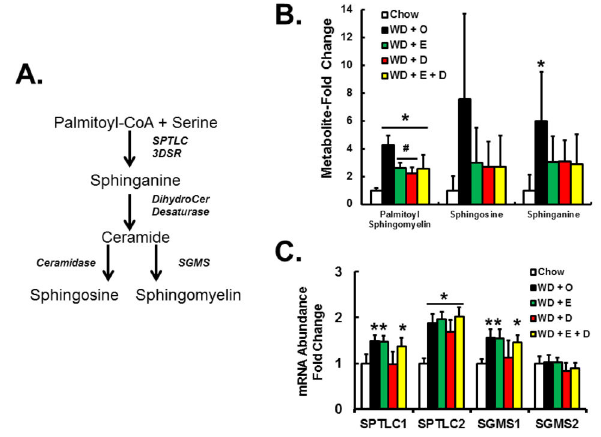
Figure 7. Diet effects on hepatic one-carbon, choline and glutathione metabolism. Panel A: Pathways for one-carbon, choline, glutathione and sphingomyelin metabolism. Panel B: Metabolites quantified by the metabolomic analysis were expressed as Metabolite-Fold Change and represented as mean ± SD, n=8 per group; *, p ≤ 0.05 versus chow; #, p ≤ 0.05 versus WD +